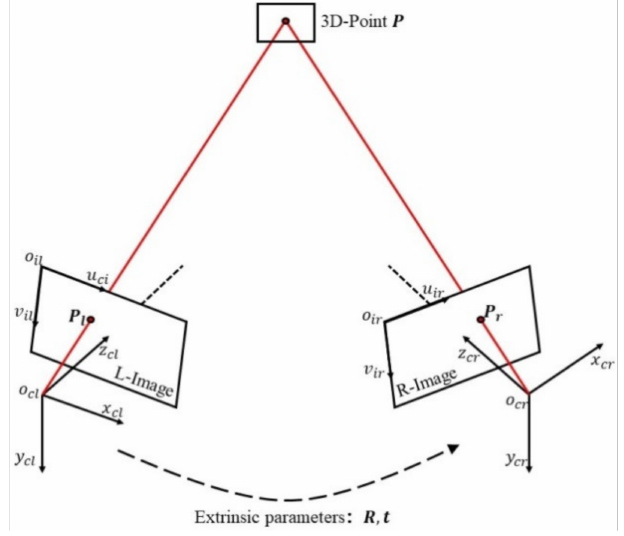
Figure 1. Binocular stereo vision